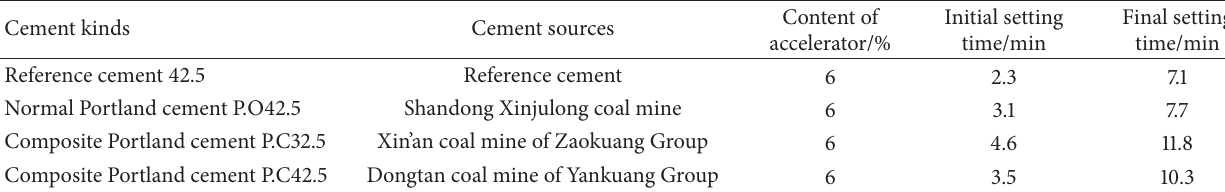
Table 13: Adaptability test of WT-1 type accelerator.